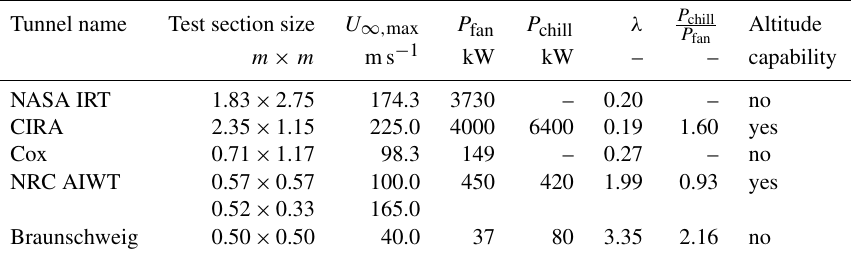
Figure 4. Overview of the Braunschweig Icing Wind Tunnel and its adjacent components. Table 1. Performance of different icing wind tunnels compared to the Braunschweig Icing Wind Tunnel. U ∞ , max represents the maximum air speed in the test section, P chill is the installed cooling power. Data extracted from Pastor-Barsi et al. (2012), Vecchione and De Matteis (2003), Al-Khalil et al. (1998) and Oleskiw et al.